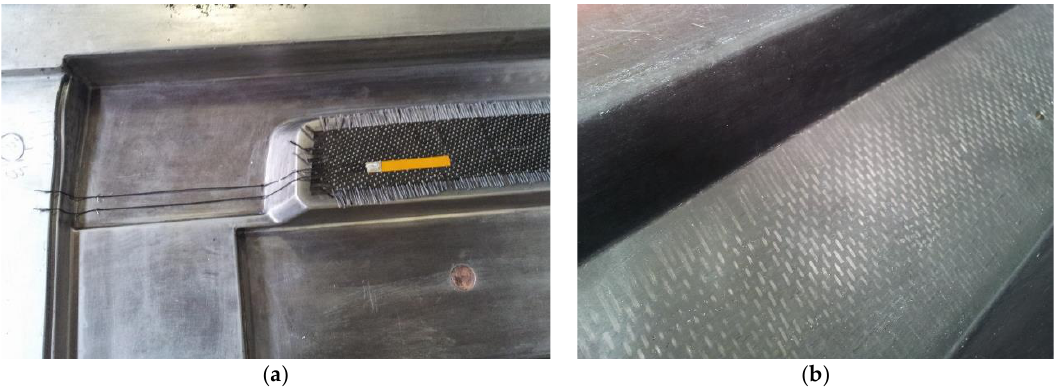
Figure 10. ( a ) Piezoelectric actuator placed on the carbon fabric just before embedding, and ( b ) textile-reinforced composite after curing.